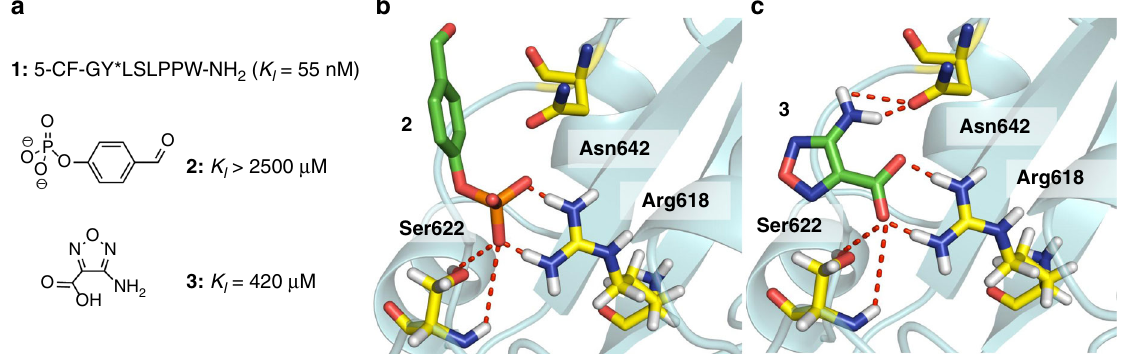
Fig. 1 Discovery of phosphate-mimetic fragment 3 . a Fluorescently labeled phosphotyrosine peptide 1 was used in an FP assay for the screening of a fragment library furnishing 4-amino-furazan-3-carboxylic acid 3 as a phosphate-mimetic 21 . Phosphotyrosine-mimetic fragment 4-formyl-phenyl phosphate 2 was employed to investigate fragment hits for second site binding. b – c Molecular docking results of fragments 2 and 3 into homology model of human STAT5b-SH2 domain, generated from the published structure of STAT5a (PDB accession codes, 1Y1U [http://dx.doi.org/10.2210/pdb1Y1U/pdb]) 30 . Hydrogen bonds with key residues in the hydrophilic binding pocket of the STAT5-SH2 domain were illustrated as red dashed